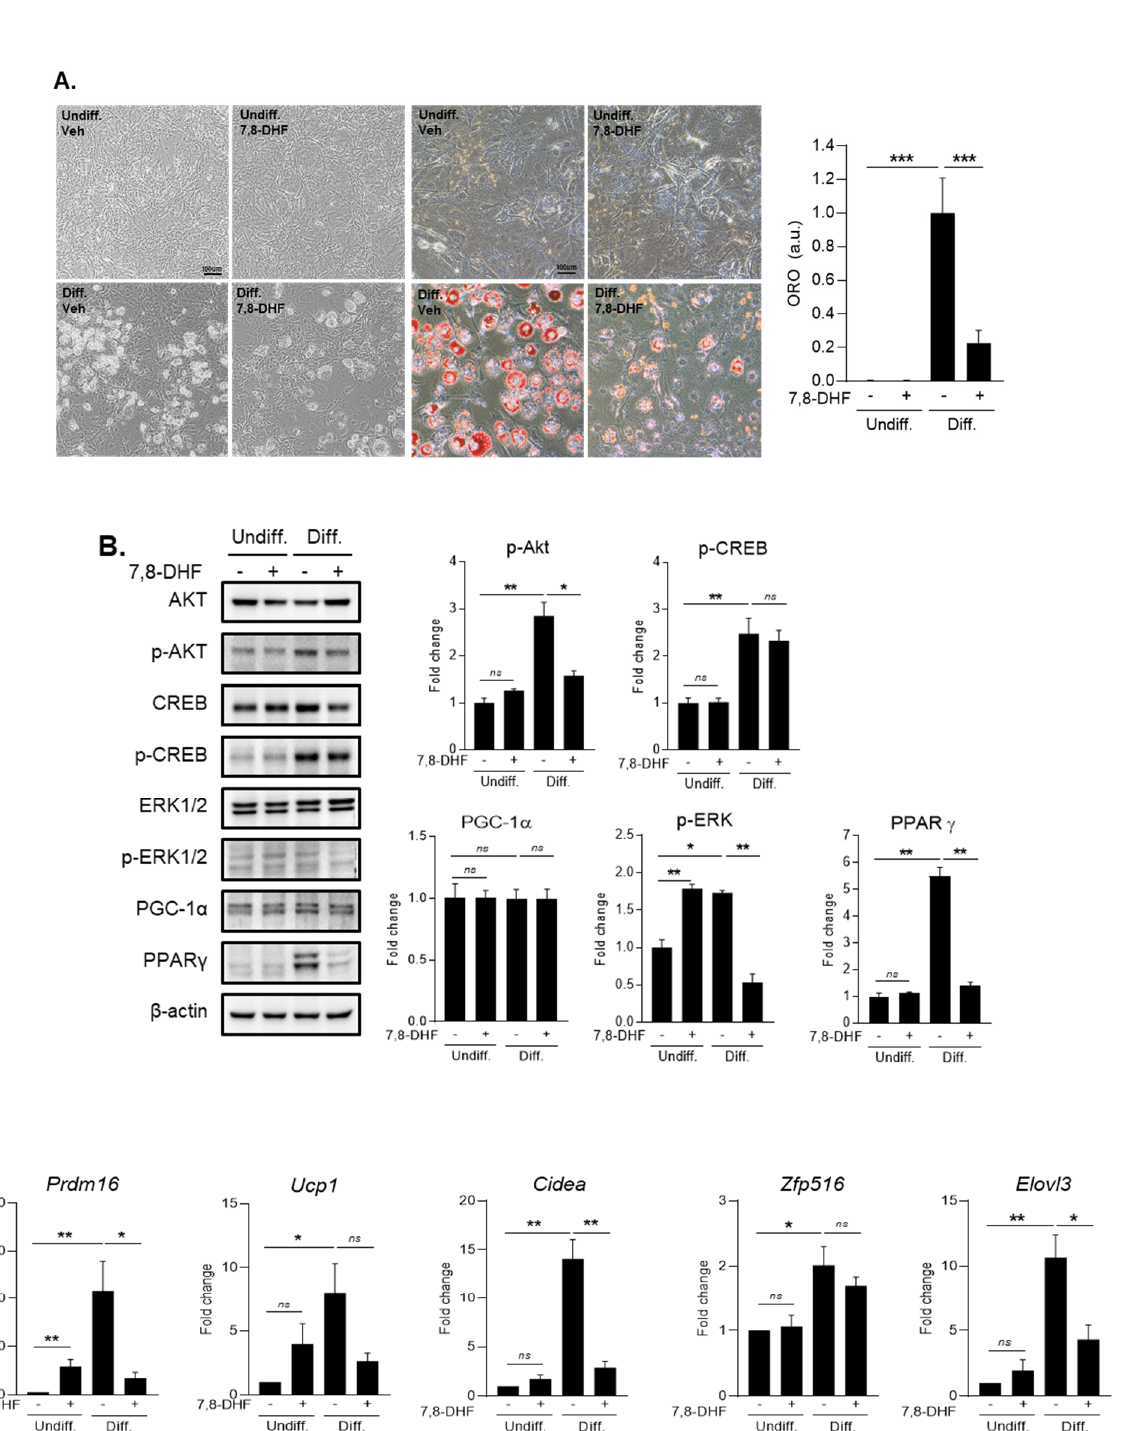
Figure 6. The effect of 7,8-DHF (BDNF mimetic) treatment in undifferentiated and differentiated 3T3-L1 adipocyte cells. ( A ) adipocyte differentiation and lipid accumulation by Oil red O staining, ( B ) protein expression related to adipocyte differentiation, ( C ) mRNA expression of genes involved in body fat-browning. Means ± S.E. tested by independent t -test (nonparametric). * p < 0.05, ** p < 0.01, *** p < 0.001, n.s.: no significance; 5 µ g/mL treatment of 7,8-DHF; undiff: undifferentiated cells, diff: differentiated cells.